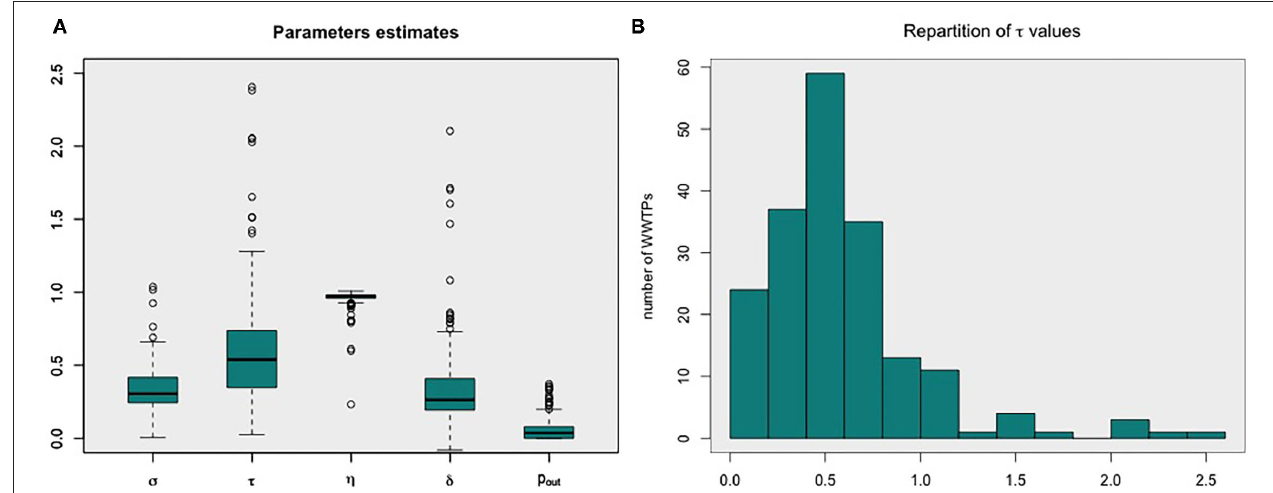
FIGURE 8 | (A) Parameters estimates for 190 Obépine WWTPs and (B) detailed distribution of the corresponding τ estimates which give an estimation of the error of the whole measurement system.